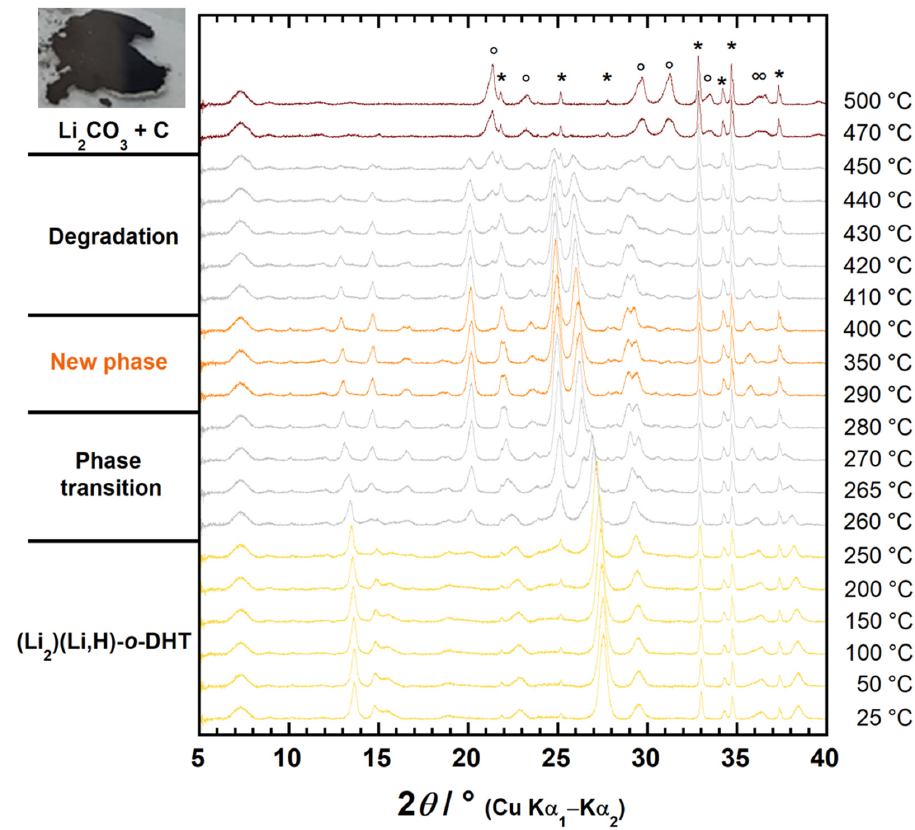
Figure 3. TRXRPD patterns collected under nitrogen flow by heating the (Li 2 )(Li,H)- o -DHT com- pound from 25 to 500 °C (° corresponds to Li 2 CO 3 diffraction peaks whereas * corresponds to the sample holder). Inset: Photograph of the as-obtained residue after pyrolysis at 500 °C showing a mixture of black and white powders.